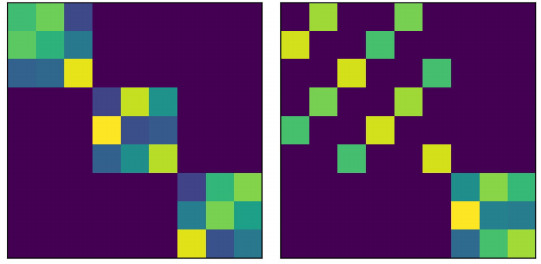
FIG. 1. The action of the M R map, 1000 times, on a random- seed unitary of size d 2 = 9 results in an approximate dual unitary that typically has all d 4 entries nonzero. The absolute values of the matrix elements in one such instance are shown.